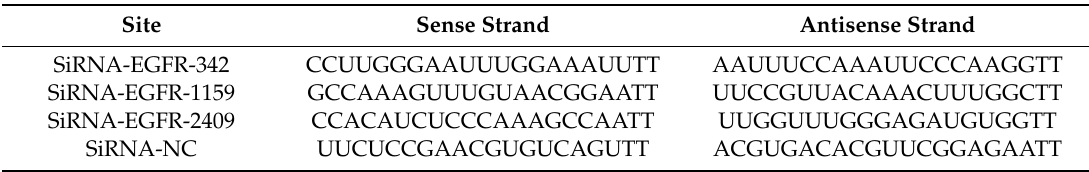
Table A1. SiRNA sequences for